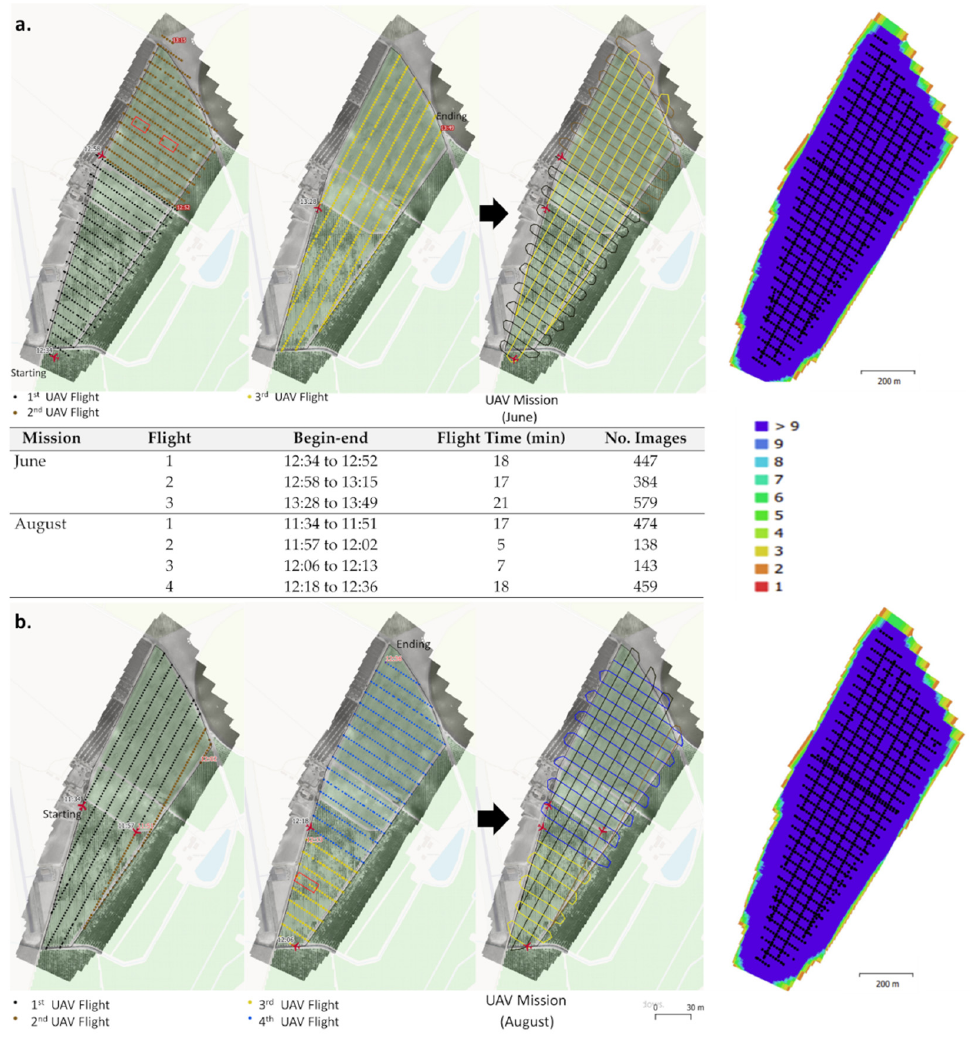
Figure 4. UAV flight for June ( a ) and August ( b ). The characterisation of each UAV flight with the flight time and the number of aerial images acquired. The red areas in the flight indicate “small disturbances” on image coverage. On the right side, the pictures show image overlaps, where the colour coding represents the number of images where the camera location appears.